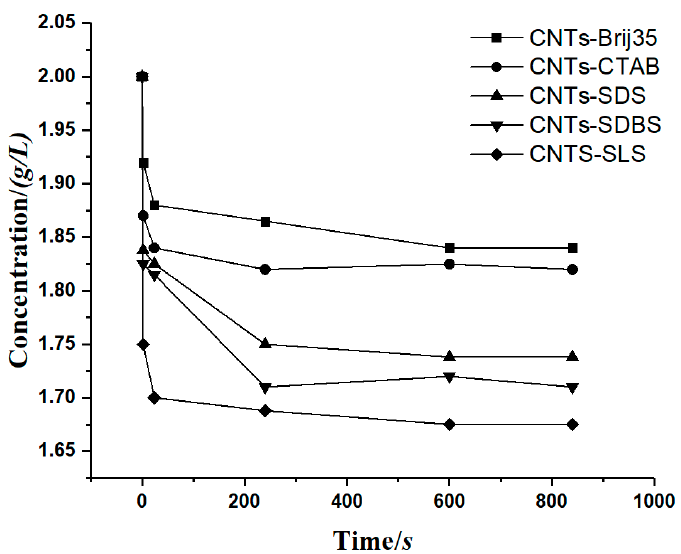
Figure 10. The relationship between the carbon nanotube suspension concentration and time.